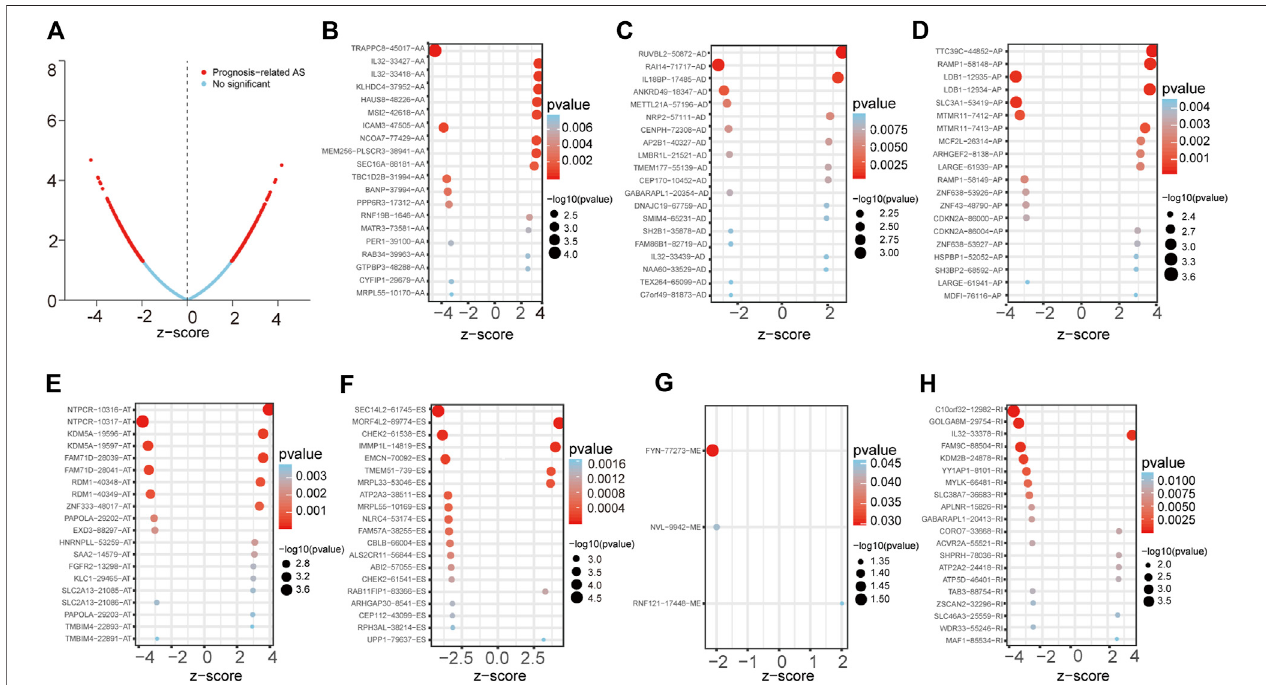
FIGURE 1 | Forest plots analyses of survival-associated AS events. (A) Volcano plot depicting the p values from univariate Cox analysis of the 30,735 AS events. (B – H) Forest plots of z-score of the top 20 signi fi cantly survival-related AS events for seven splicing types (ME only three events).